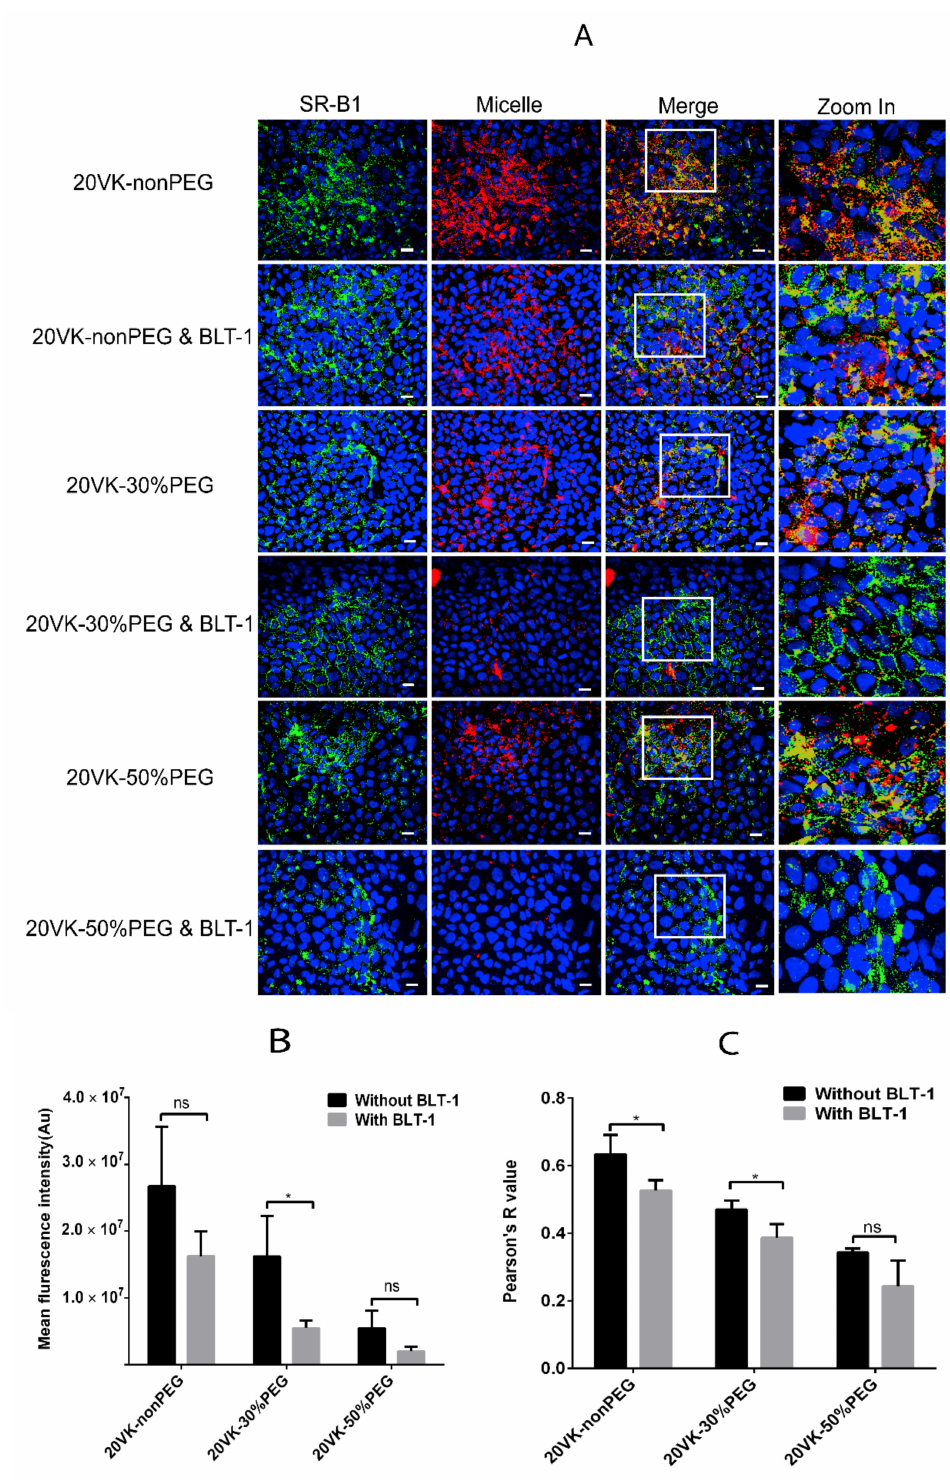
Figure 2. ( A ) Confocal fluorescence microscopy pictures of differentiated Caco-2 cells incubated for 2 h at 37 ◦ C with rhodamine-labeled mixed micelles (red) and immunofluorescence staining (green) of SR-B1, with and without pre-treatment with 10 µ M BLT-1. Corresponding fluorescence intensity of rhodamine ( B ) and Pearson’s coefficients of red and green fluorescence ( C ) to reflect the colocalization degree of SR-B1 with mixed micelles; data shown as mean ± SD ( n = 3, two-tail unpaired t -test, * p < 0.05, ns is not